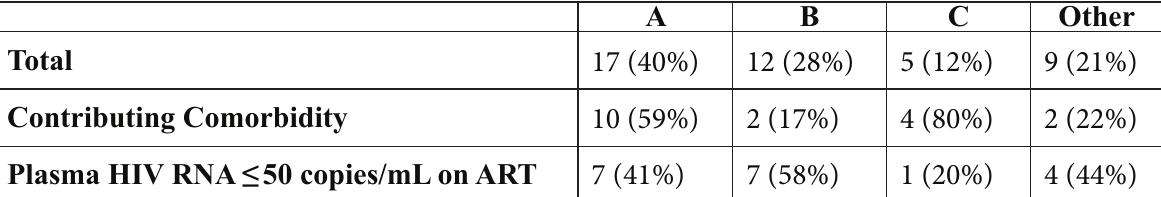
Supplementary Table 4. Distributions of the populations for the secondary analyses in the par- ticipants of Hispanic ancestry, broken out by major haplogroups A, B, and C.